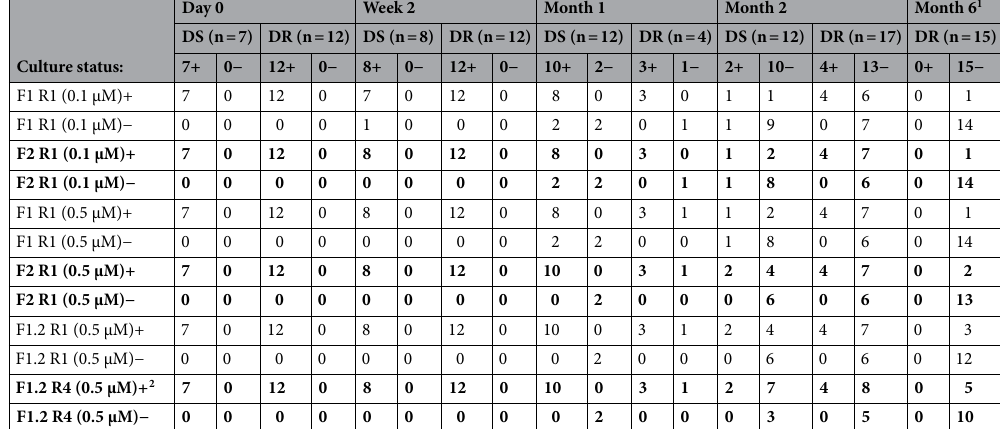
Table 5. qRTPCR positivity by the different 16S rRNA primer sets in comparison to culture for sputa from subjects with drug sensitive (DS) or drug resistant (DR) TB receiving first-line or second-line therapies, respectively. 1 Month 6 post-initiation of therapy samples were only collected from subjects with DR TB due to their longer (20 month) treatment regimen. 2 The final primer set ‘F1.2 R4 0.5 µM’ was unable to distinguish between live/dead H37Rv (Table 4) but was included as a comparator since it has the lowest limit of detection of any 16S rRNA primer set tested; n-values represent number of sputum available at each timepoint for each cohort (see “Materials and methods” section); Cycle threshold (Ct) values can be found in Table S19. Rows corresponding to different primer sets are alternately bolded for visual aid.